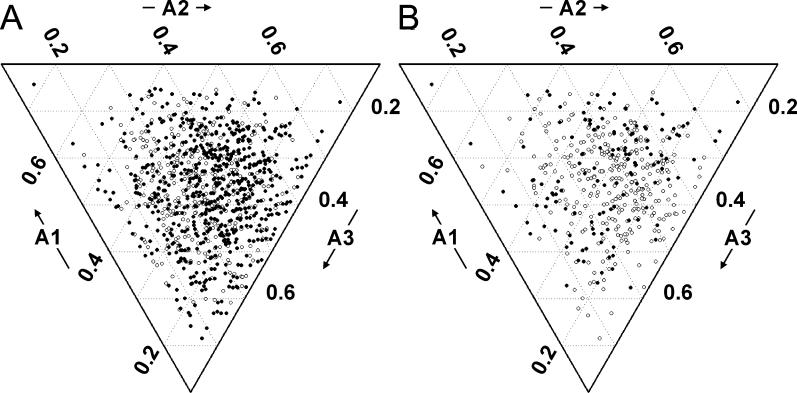
Ternary Diagrams Showing the Distribution of Chimera Amino Acid Compositions(A) Compositions of 955 folded (closed circles) and not-folded (open circles) chimeric sequences. Each data point represents the relative amino acid identity between a chimera and each parental sequence not including positions conserved between all three parents. This distance was calculated by determining the number of amino acids a chimera shares with each parent and dividing by their sum. The three relative identities add up to one. Since each parent shares some sequence identity with the other two, they do not lie at the corners of the diagram.(B) Compositions of 441 chimeras tested for activity on 12-pNCA: active chimeras (closed circles) and not active (open circles). Chimeras composed mostly of A3 and chimeras near the center tend to be inactive on 12-pNCA.